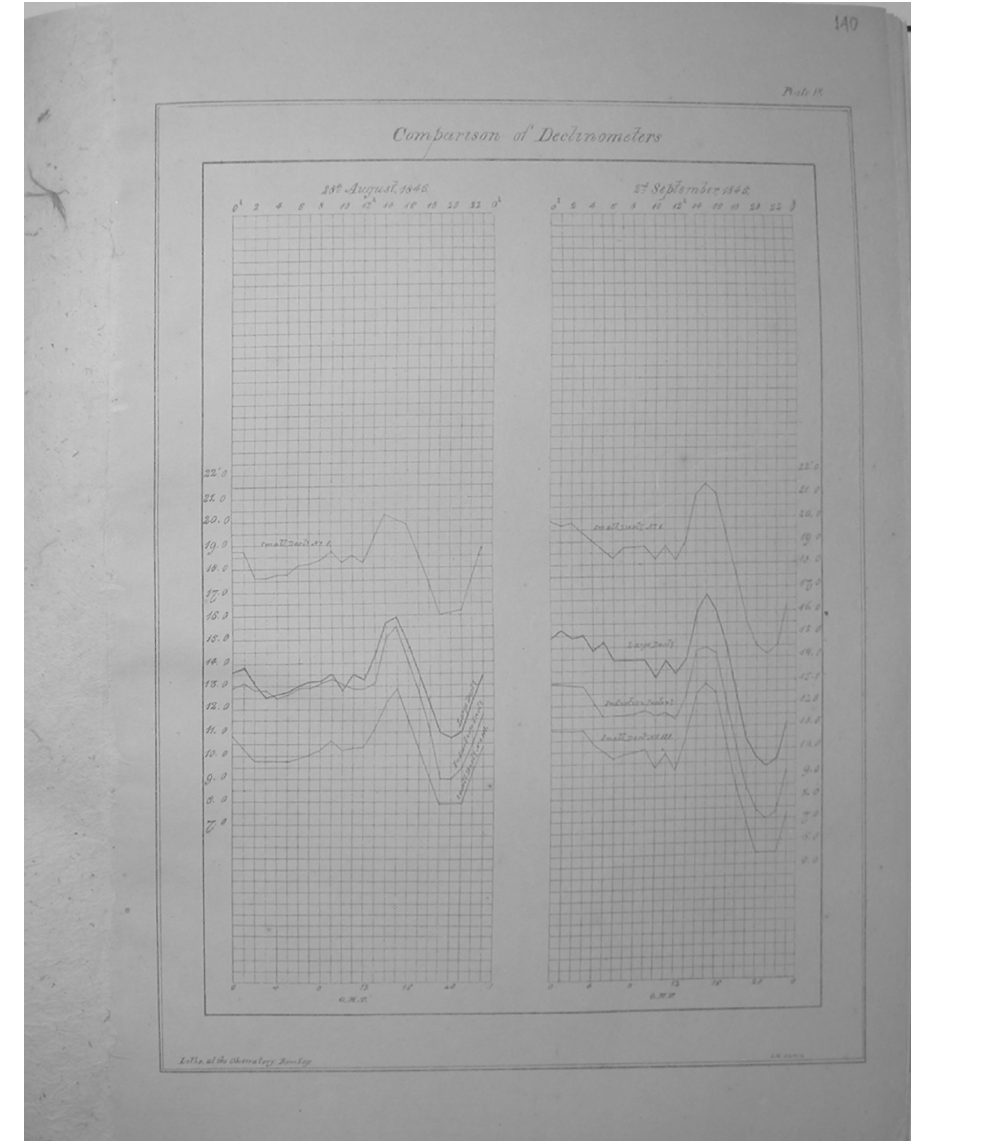
Figure 8. Comparison of declinometers carried to ascertain reasons for anomalous diurnal variation (Orlebar,